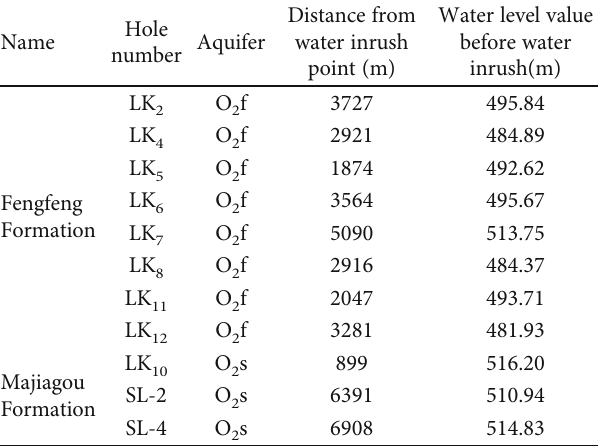
Figure 5: Variations in water fl ow at the water inrush point with Table 1: Variation in the water level of Ordovician limestone before water inrush as a function of distance.